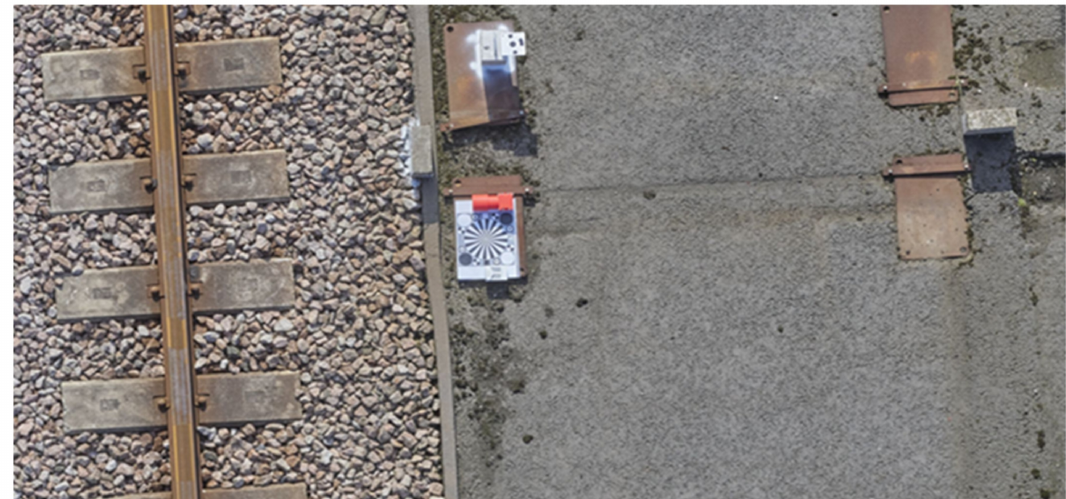
Figure 14. Aerial image containing a Siemens-star.